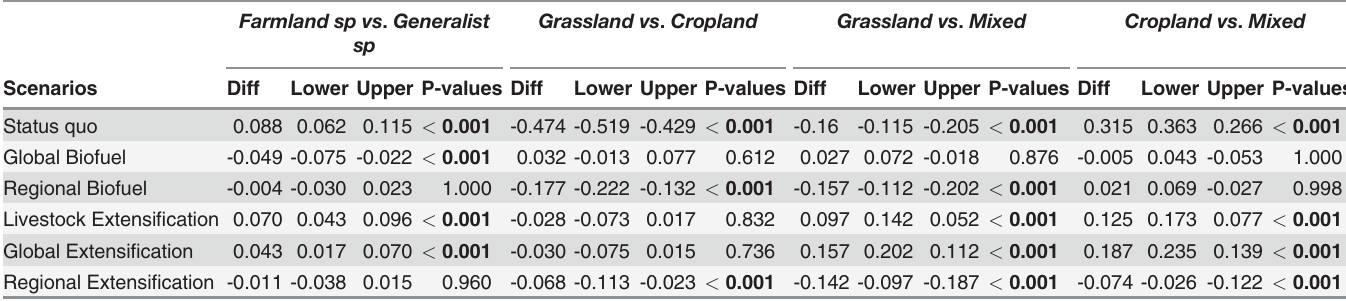
Table 3. Differences between mean changes in populations of farmland and generalist bird species, and between mean changes in populations of farmland specialists (grassland, cropland and mixed species) in response to each farmland cover scenarios. Farmland sp vs . Generalist Grassland vs . Cropland Grassland vs . Mixed Cropland vs . sp